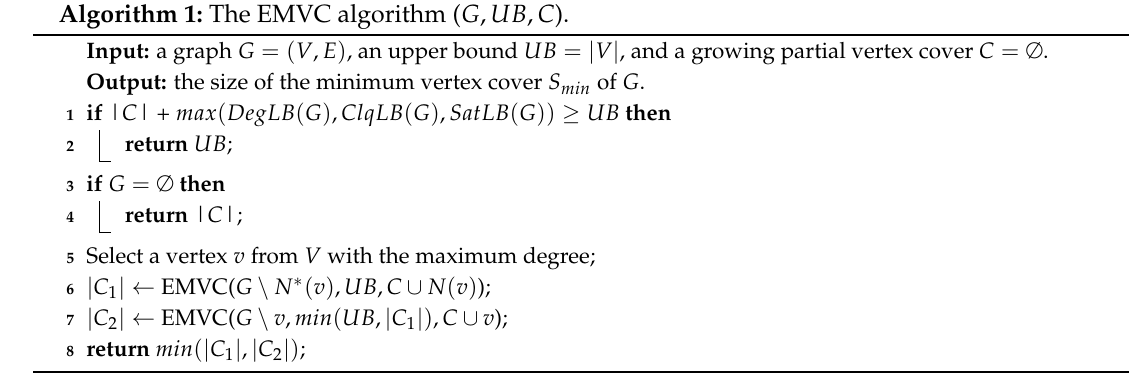
Algorithm 1: The EMVC algorithm ( G , UB , C